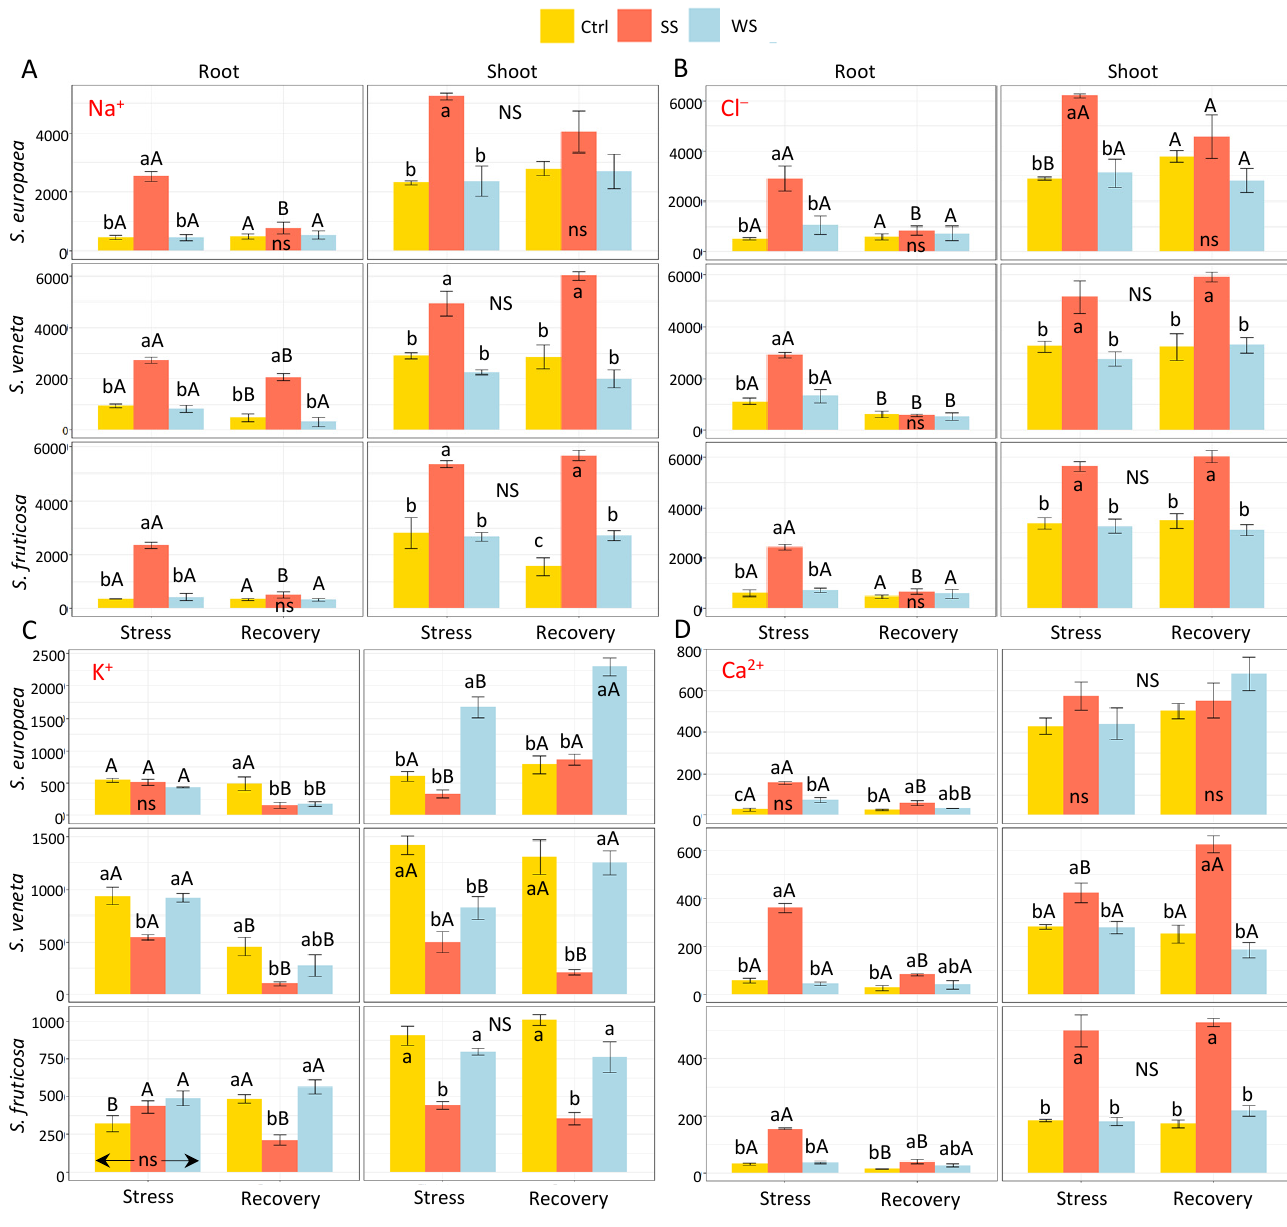
Figure 4. Effect of 30 days of stress treatments (Stress) followed by watering with non-saline water for 15 days (Recovery) on the root and shoot concentration (in µ mol g − 1 DW) of ions: ( A ) sodium (Na + ), ( B ) chloride (Cl − ), ( C ) potassium (K + ), and ( D ) calcium (Ca 2+ ) in the three halophytes. Ctrl, control; SS, salt stress (watering with 700 mM NaCl); WS, water stress (complete withholding of irrigation). For each species and sampling (Stress or Recovery), different lowercase letters over the bars indicate significant differences between treatments (Ctrl, SS, and WS), at p ≤ 0.05; ns: non-significant. Different uppercase letters indicate significant differences between the two samplings (Stress and Recovery) for each species and treatment, at p ≤ 0.05; NS: non-significant. Vertical bars indicate standard error ( n =